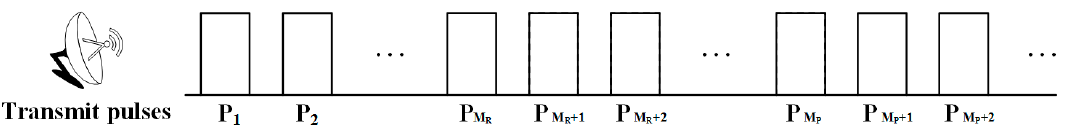
Figure 1. Sampling scheme of periodically gapped sampling in the azimuth direction.